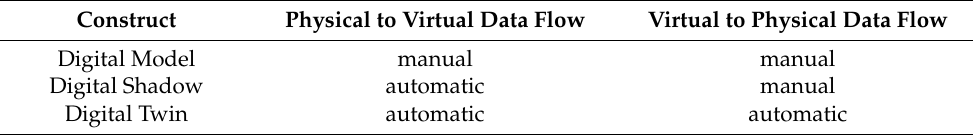
What Is Digital